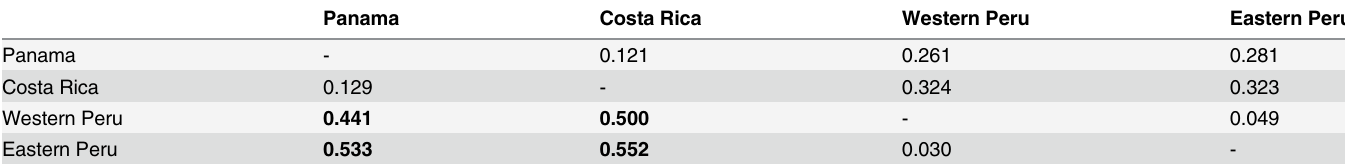
Table 3. Pairwise measures of genetic differentiation between F . insipida populations. F ST (above diagonal) and R ST (below diagonal). If R ST > per- muted R ST , it is indicative for the contribution of mutations to population differentiation (for p < 0.05 after correction for multiple testing indicated by bold